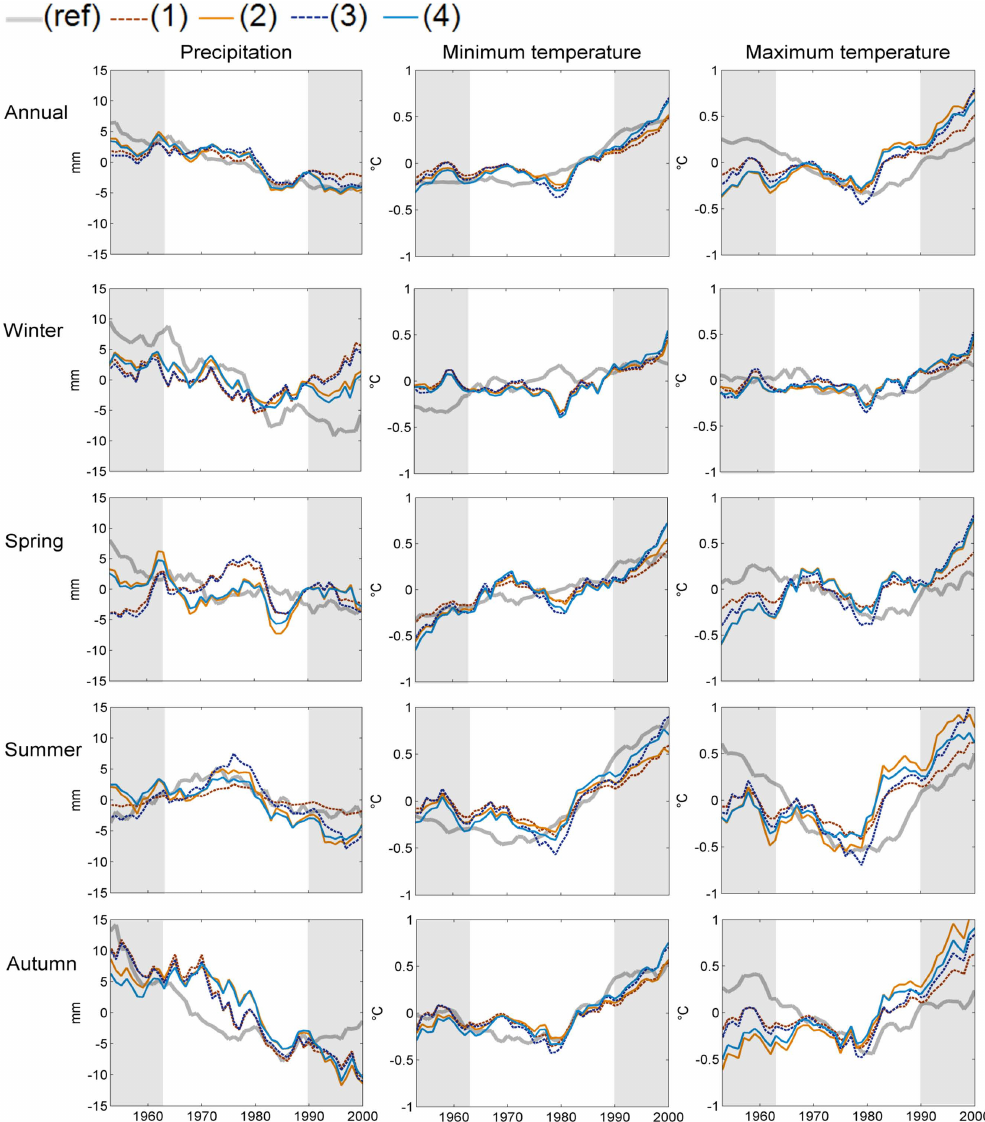
Fig. 6. Annual and seasonal mean of quantiles variation between the quantiles computed on a 21yr window and on the whole period. Precipitation, minimum and maximum temperature analysis for land observations (ref), GCM (1), GCM-DD (2), GCM-SD (3) and GCM- DD-SD (4). Grey rectangles represent values computed with less than